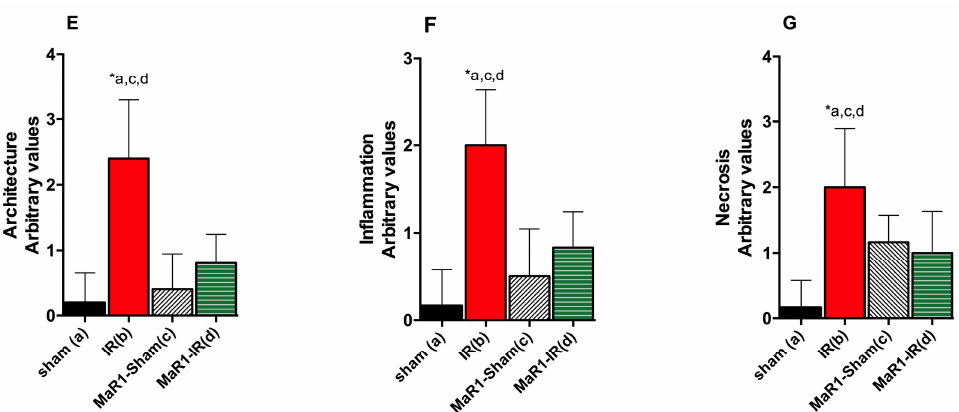
Figure 2. Effect of MaR1 on liver morphology after IR. ( A – D ) Representative liver sections stained with hematoxylin-eosin (H and E), magnification 100× and 400×, scale bar = 100 μm, from a total of 9 animals per experimental group. Scores of liver H and E sections were graphed for ( E ) architecture, ( F ) inflammation and ( G ) necrosis. Values correspond to the means ± standard deviation (SD) of 9 animals per experimental group. Asterisk indicates p < 0.05 and the letters identify the experiments that are compared and present this statistical difference. CV: Central vein. Black arrow indicates focal necrosis hepatocytes.